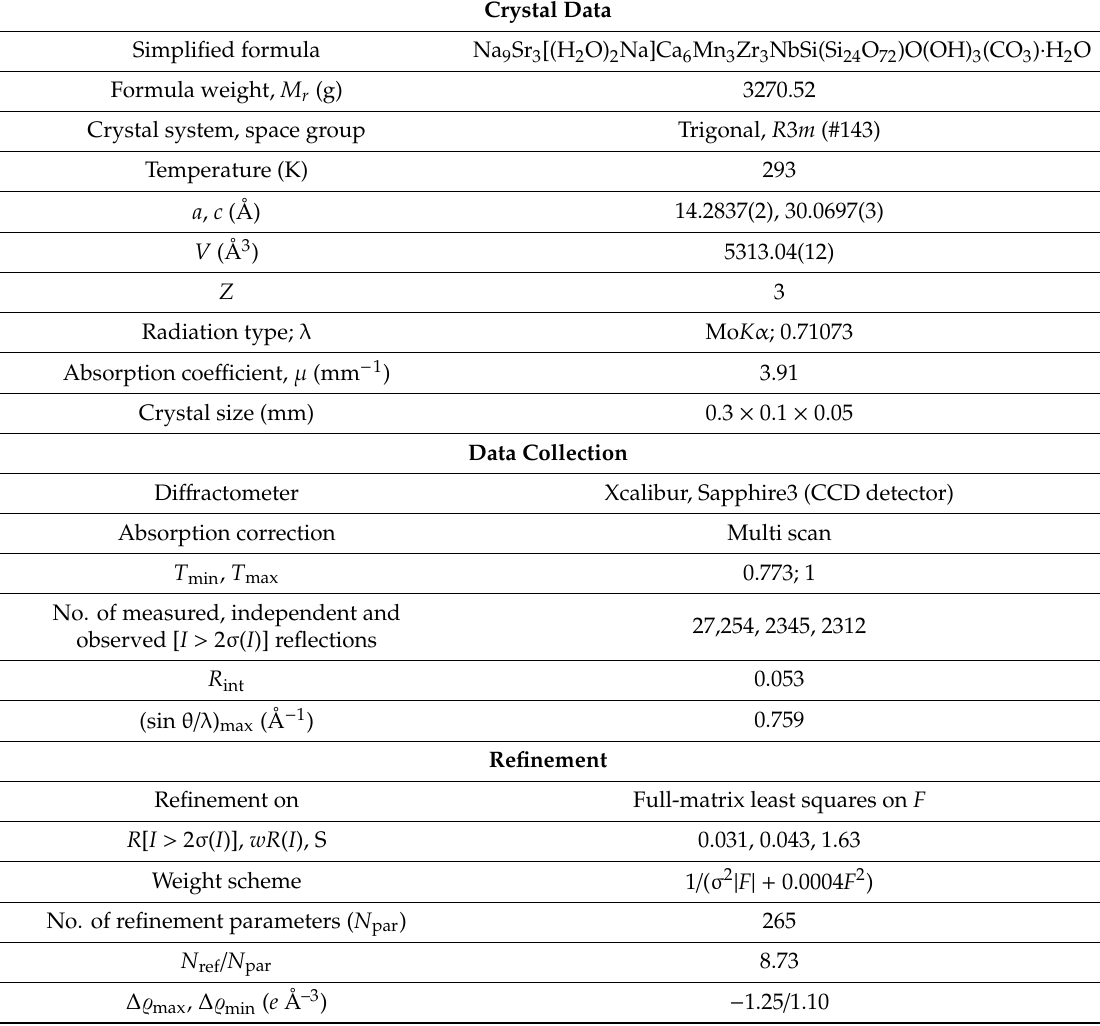
Table 1. Crystal data, data collection information and structure refinement details for